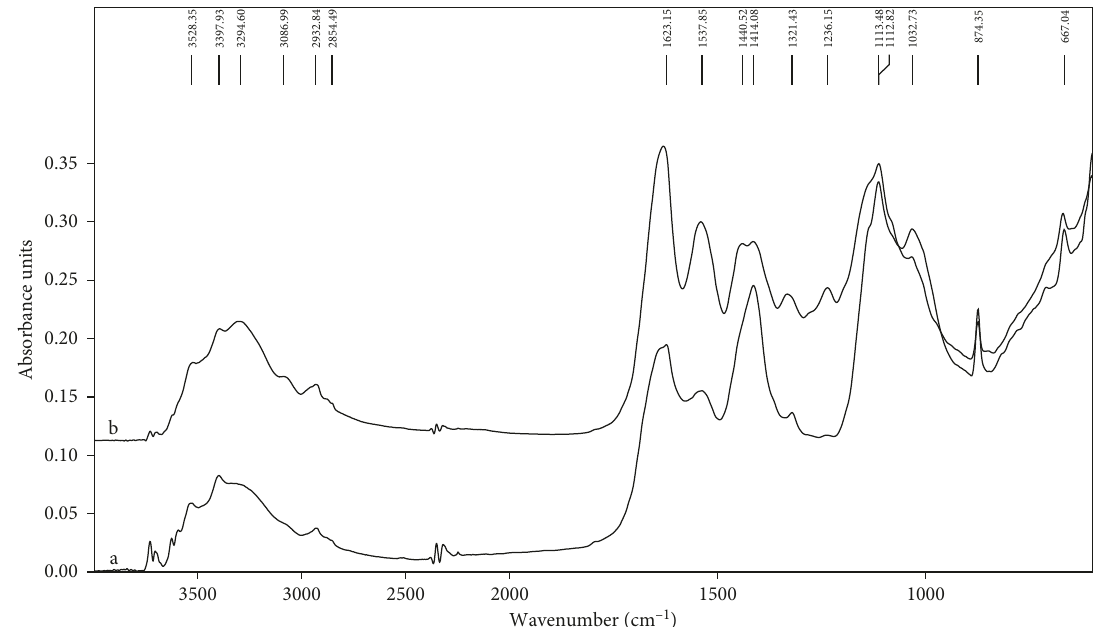
Figure 3: ATR-FTIR spectra of the inked area: (a) Parch. 34 and (b) related parchment.